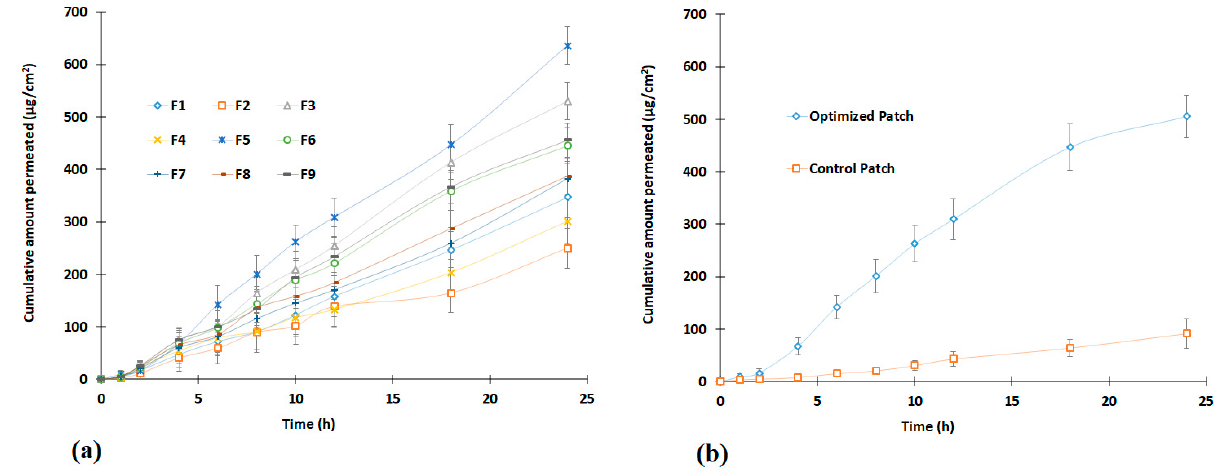
Figure 6. Permeation profiles of treprostinil from design batches (F1–F9) ( a ) and optimized transdermal patch ( b ) (n = 6). The control patch contains the same amount of drug without